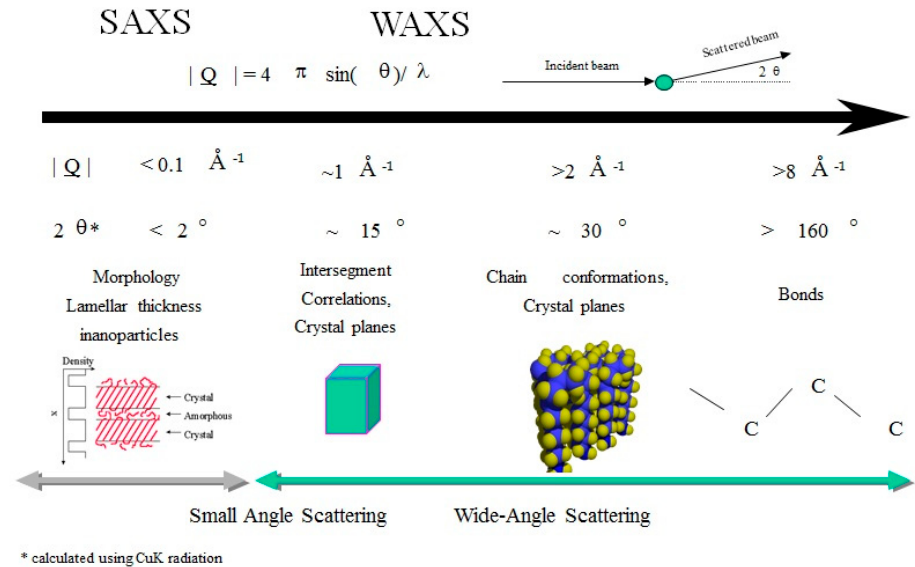
Figure 1. Schematic representation of the di ff erent correlations available by the use of di ff raction methods in the study of amorphous polymers.